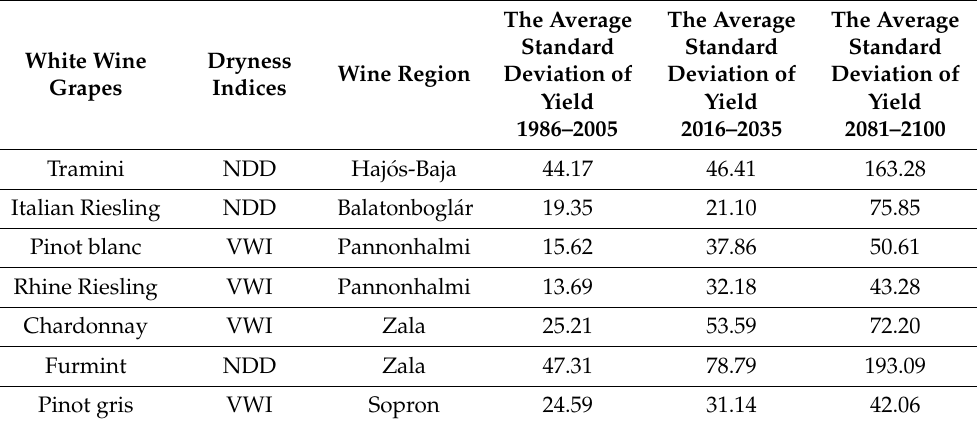
Table 10. Values of standard deviations of estimated white wine grape yields are produced based on the regression coefficients of the best regression fits of dryness indices in different 20-year periods. Significant differences are set in italic. For the distant future, all selected dryness indices initiate significantly higher variability, whereas between the near future and recent past four standard deviations become significantly